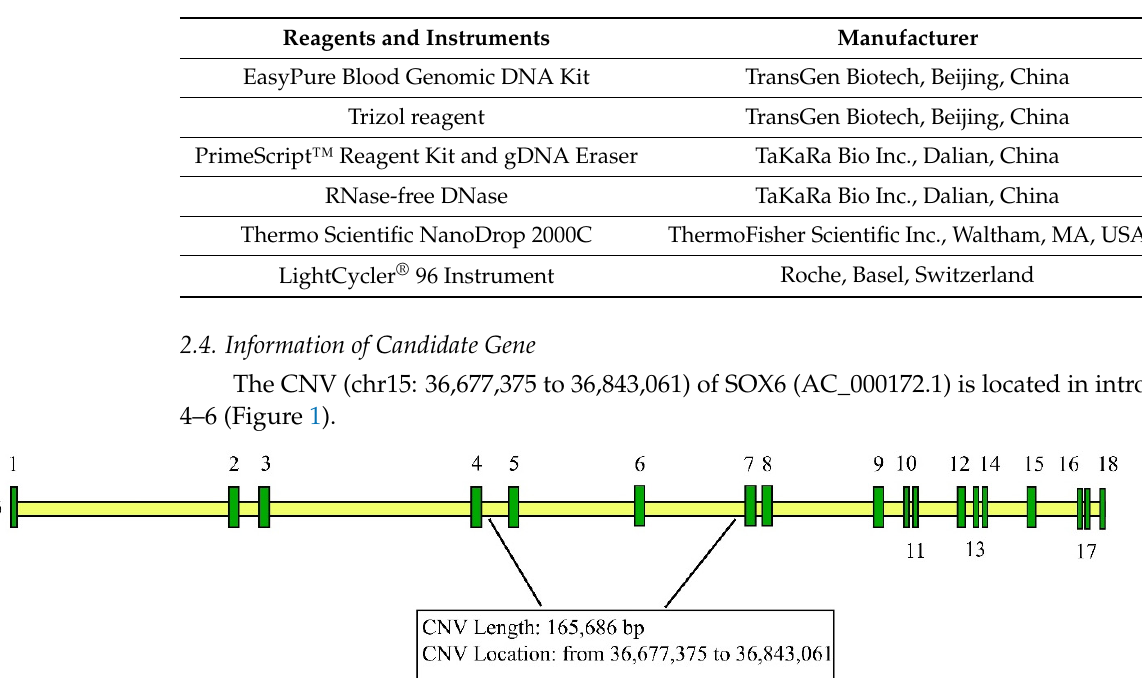
Table 1. Main test reagent equipment and manufacturers.